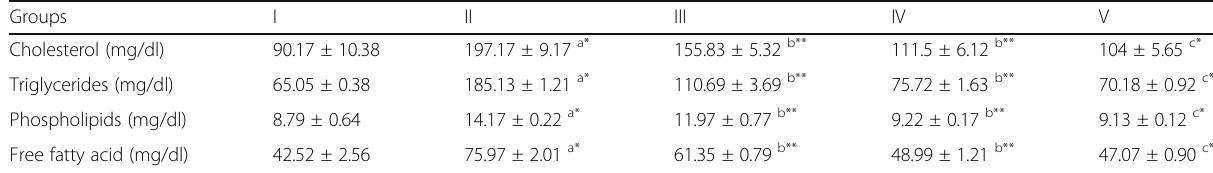
Values are mean±S.E.M ( n =6) a* P <0.05 statistically significant when disease control(Group II) compared with normal control (Group I), b** P <0.05 statistically significant when AECB treated (Group III,IV) compared with disease control groups(group II), c* P <0.05 statistically significant when AECB treated (Group III,IV) compared with standard drug treated(Group V)